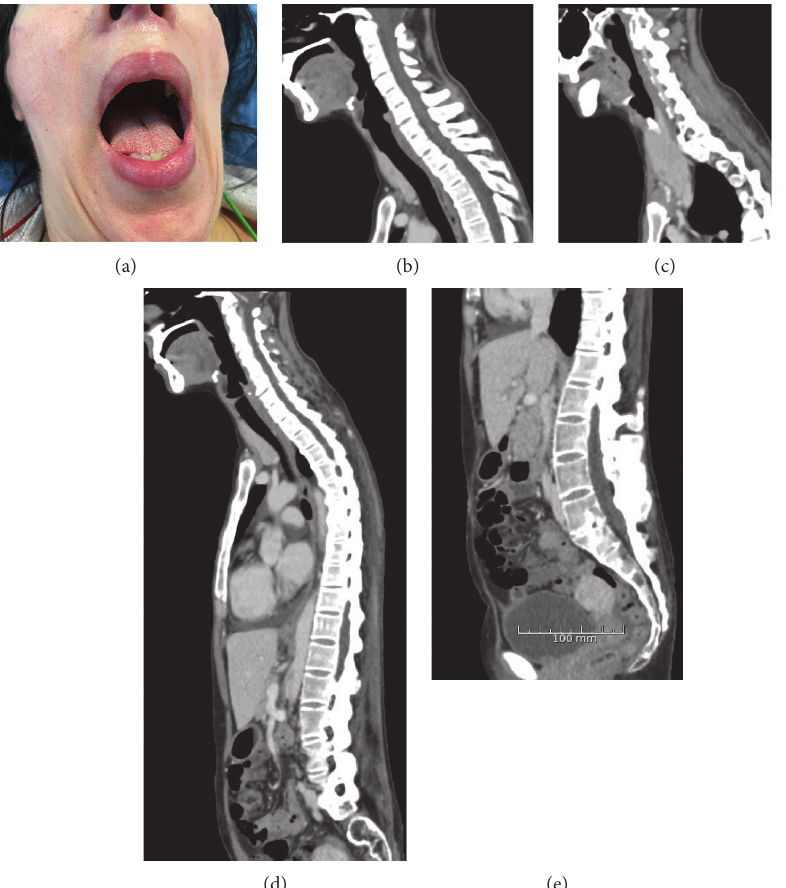
Figure 1: The patient demonstrating mouth opening of 25mm (a). CT scan of the cervical column showing the midline view with block vertebrae C2/C3 and C5/C6 (b) and paramedian view showing fusion of facet joints C2–C6 (c). Ossification of the anterior longitudinal ligament with anterior bridging osteophytes seen in the thoracic region (d) and fusion of all spinous processes in the lumbar region